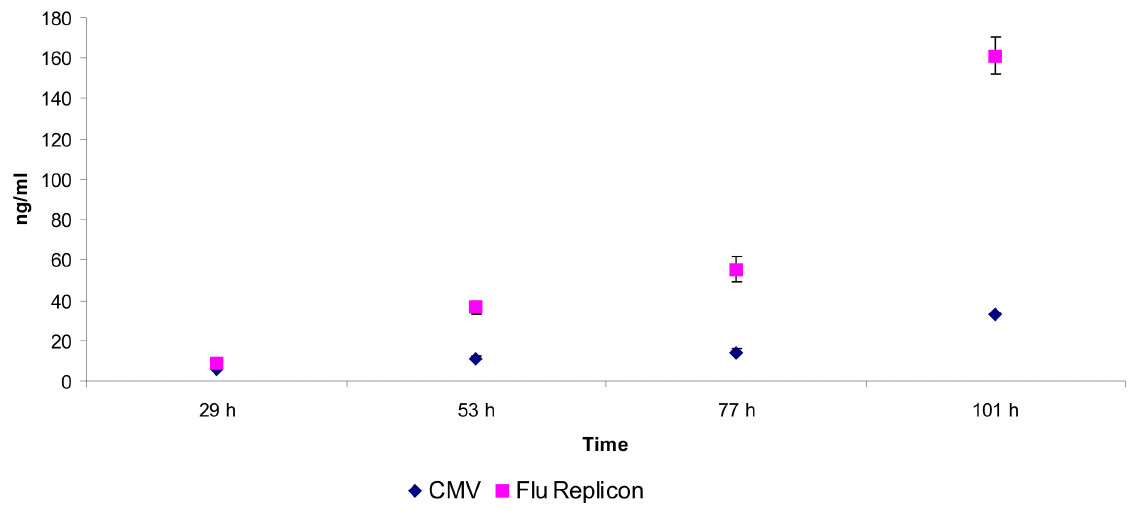
Figure 12. Light chain expression. HEK-293 cells were either tranfected with pRC-LC (CMV) or with the influenza replicon and pMono-LC (Flu Replicon). Light chain concentration in the culture supernatant was monitored for 101 hours by ELISA. Data represents arithmetic mean values and standard deviation.